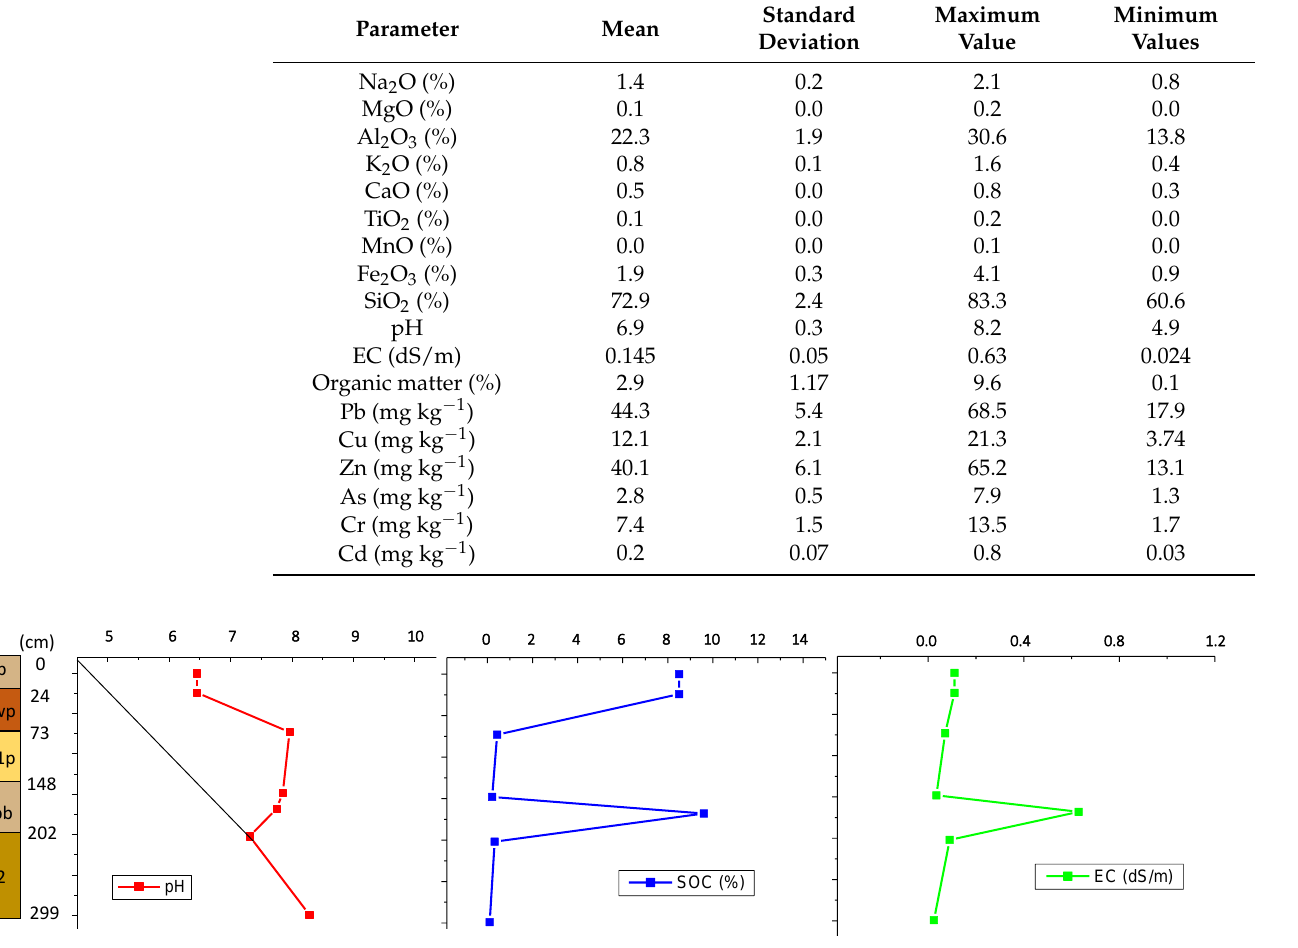
Figure 3. Values of pH, soil organic carbon (%) and electric conductivity (dS/m) in the studied soil profile.